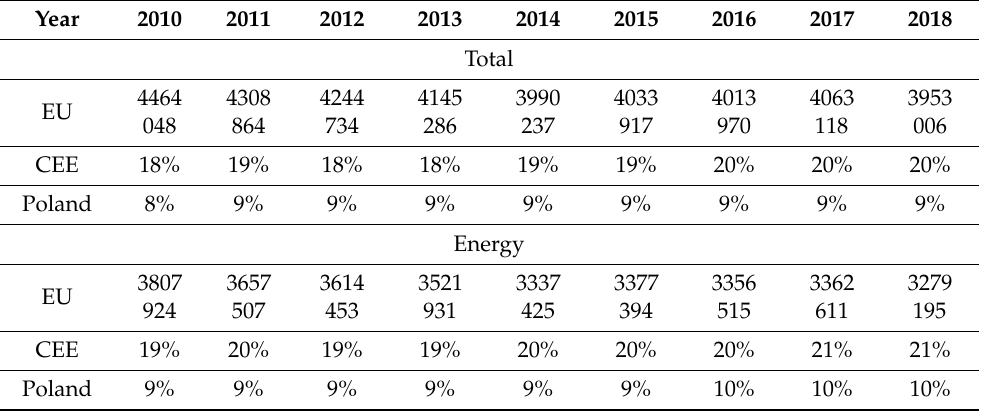
Figure 3. Greenhouse gases—energy (CO 2 , N 2 O in CO 2 equivalent, CH 4 in CO 2 equivalent, HFC (Hydrofluorocarbon) in CO 2 equivalent, PFC (Perfluorocarbons) in CO 2 equivalent, SF6 in CO 2 equivalent, NF3 in CO 2 equivalent) in thousand tonnes. Source: own calculations based on Eurostat database (2020). Table 1. Greenhouse gases—total and in energy sector (CO 2 , N 2 O in CO 2 equivalent, CH 4 in CO 2 equivalent, HFC in CO 2 equivalent, PFC in CO 2 equivalent, SF6 in CO 2 equivalent, NF3 in CO 2 equivalent) in thousand